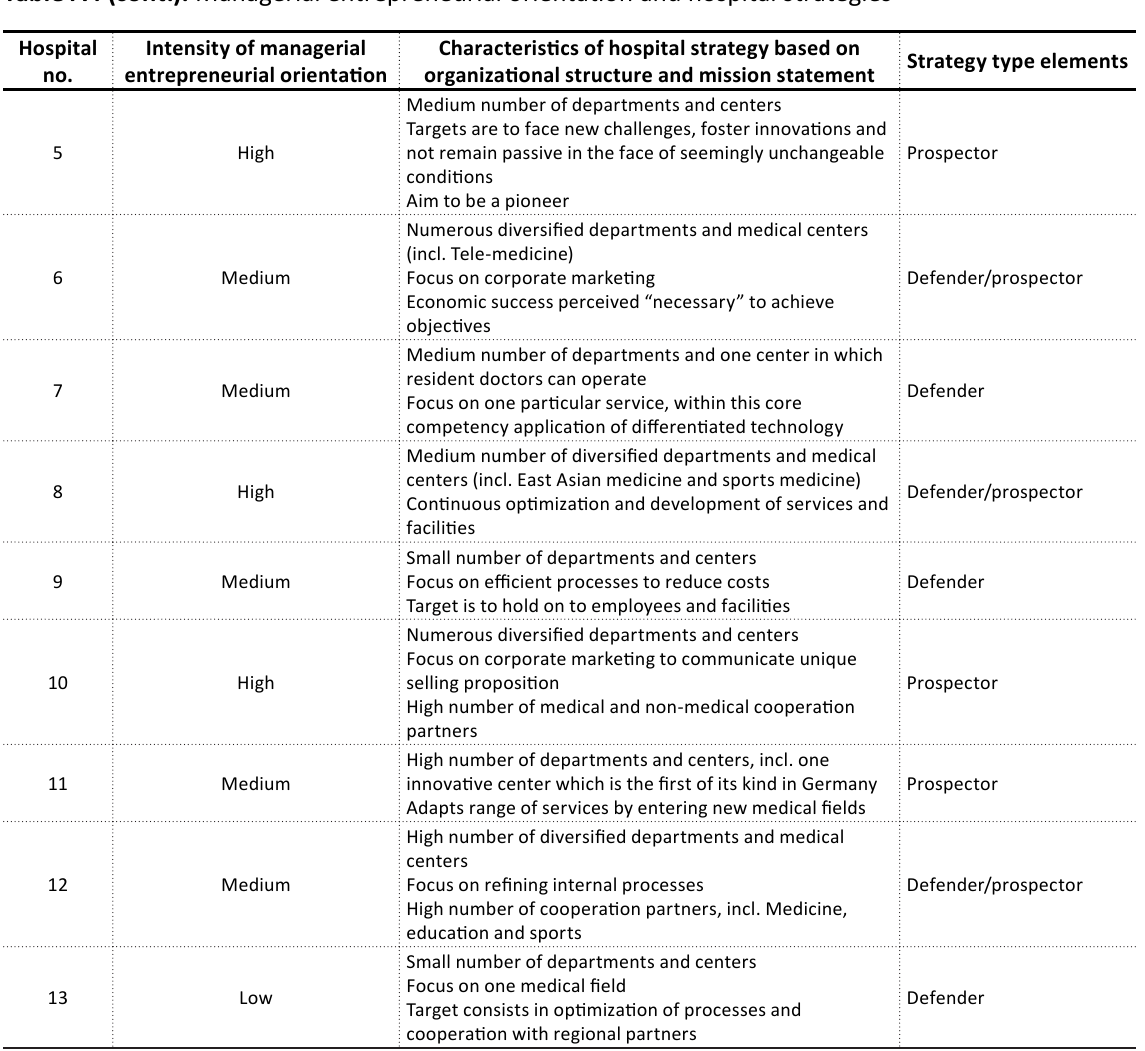
Table A4 (cont.). Managerial entrepreneurial orientation and hospital